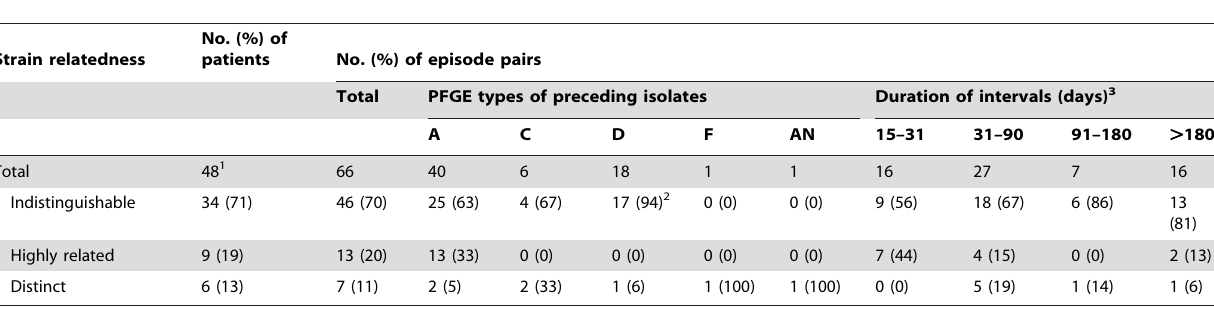
Table 4. Strain relatedness in 66 pairs of repeated MRSA infection episodes, categorized according to PFGE types of preceding isolates and